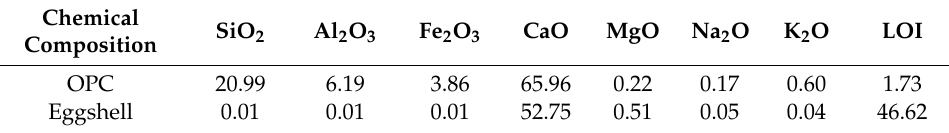
Figure 4. Activity test of ESP. 3.2. Aging Test